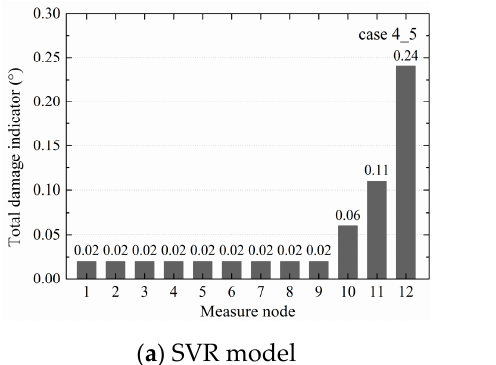
Figure 12. Flowchart of the regression model algorithm for local damage identification.